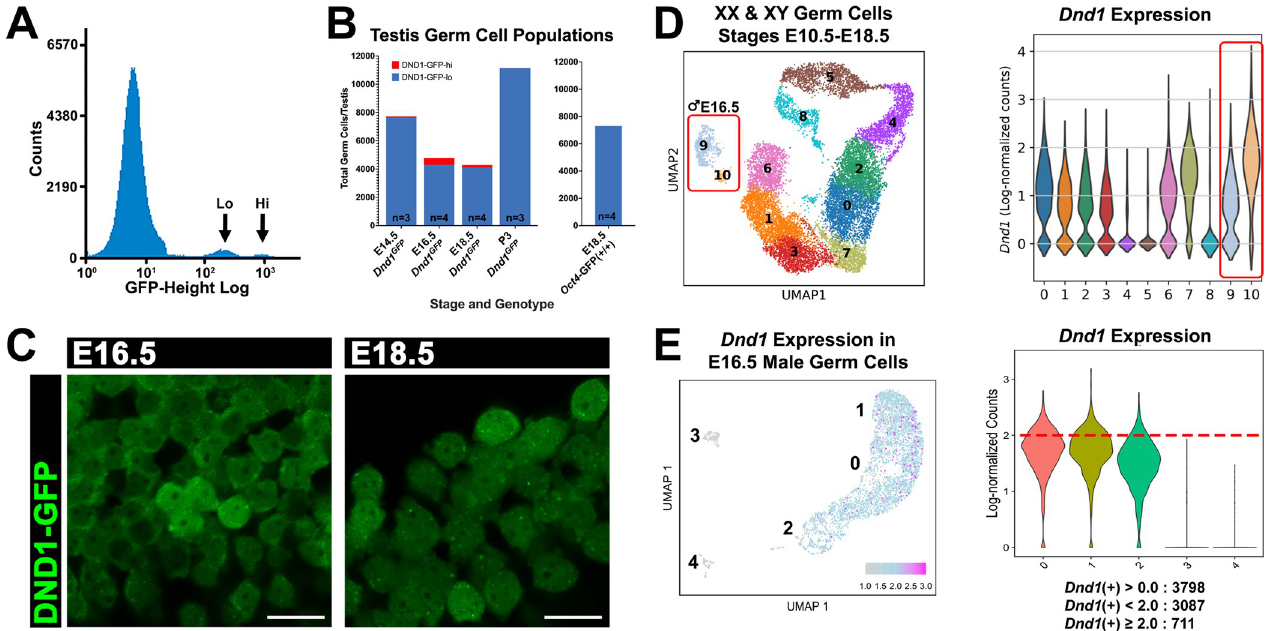
Fig 1. Fetal male germ cells express low or high levels of DND1-GFP and Dnd1 . A: FACS histogram showing one DND1-GFP-negative, and two DND1-GFP-positive populations, representing DND1-GFP-lo and DND1-GFP-hi cells at E18.5. B: FACS quantification for the number of DND1-GFP-lo and DND1-GFP-hi germ cells from E14.5, E16.5, E18.5, P3 DND1-GFP testes (n = 3,4,4,3 respectively). FACS analysis of germ cells from E18.5 Oct4 -GFP testes (n = 4) did not show GFP low and high subpopulations. C: Whole mount confocal imaging of unstained freshly dissected E16.5 and E18.5 DND1-GFP testes showing heterogenous endogenous DND1-GFP fluorescence. Scale bar = 20 μ m. D: scRNA-seq UMAP for XX and XY germ cell populations from E9.0-E16.5 [32] and violin plot showing DND1 expression levels in clusters 0–10. Red box surrounds E16.5 male germ cell populations represented by clusters 9 and 10. Corresponding violin plots show that clusters 9 and 10 contain cells expressing low and high levels of Dnd1 respectively. E: re-analysis of E16.5 male germ cell scRNA-seq from [31]. UMAP colored to show low to high levels of Dnd1 expression (grey to blue to pink). Violin plot showing levels of Dnd1 expression in clusters 0, 1, 2, 3, and 4, with a level of 2.0 denoted by red broken line. Quantification of total number of Dnd1 -expressing cells with expression � 2.0 = 711 (of 3798 total DND1+ cells).